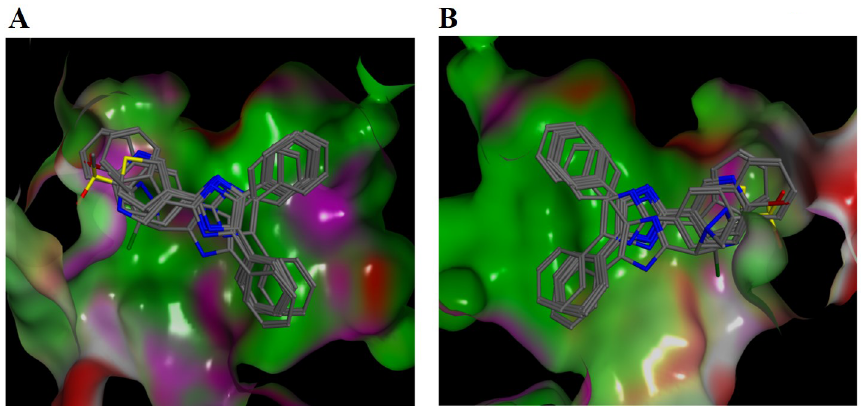
Fig 6. In silico molecular docking studies of trisubstituted imidazoles against kinase domain of Akt2: Common binding poses of trisubstituted imidazoles towards the Akt2 kinase domain. The molecular surface of the protein is represented based on the surface polarity; green, pink and red colours show hydrophobic, polar and solvent exposed regions, respectively. For the sake of better visualisation of the binding pocket surface of Akt2, molecular surface was rendered in two panels (A and B) in which ligands were rotated 180